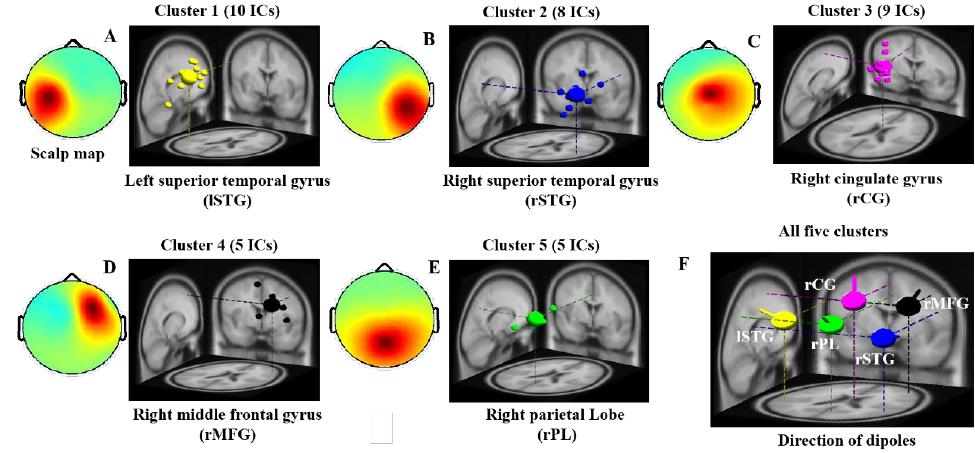
Figure 3. Scalp maps and dipole source locations of five groups of independent components (IC) in all subjects. Right panel: Plot of 3D dipole source locations and their projections onto the MNI brain template: ( A ) left superior temporal gyrus (lSTG), ( B ) right superior temporal gyrus (rSTG), ( C ) right cingulate gyrus (rCG), ( D ) right middle front gyrus (rMFG), ( E ) right parietal lobe (rPL) and ( F ) the direction of five dipoles. Left panel: average maps of the scalp from all independent components within a cluster. Cluster 1 — left-superior temporal gyrus ( n = 10). Cluster 2 — right-superior temporal gyrus ( n = 8). Cluster 3 — right-cingulate gyrus ( n = 9). Cluster 4 — right-middle frontal gyrus ( n = 5). Cluster 5 — right-parietal lobe ( n = 5). n is the number of diploes estimated in a cluster.